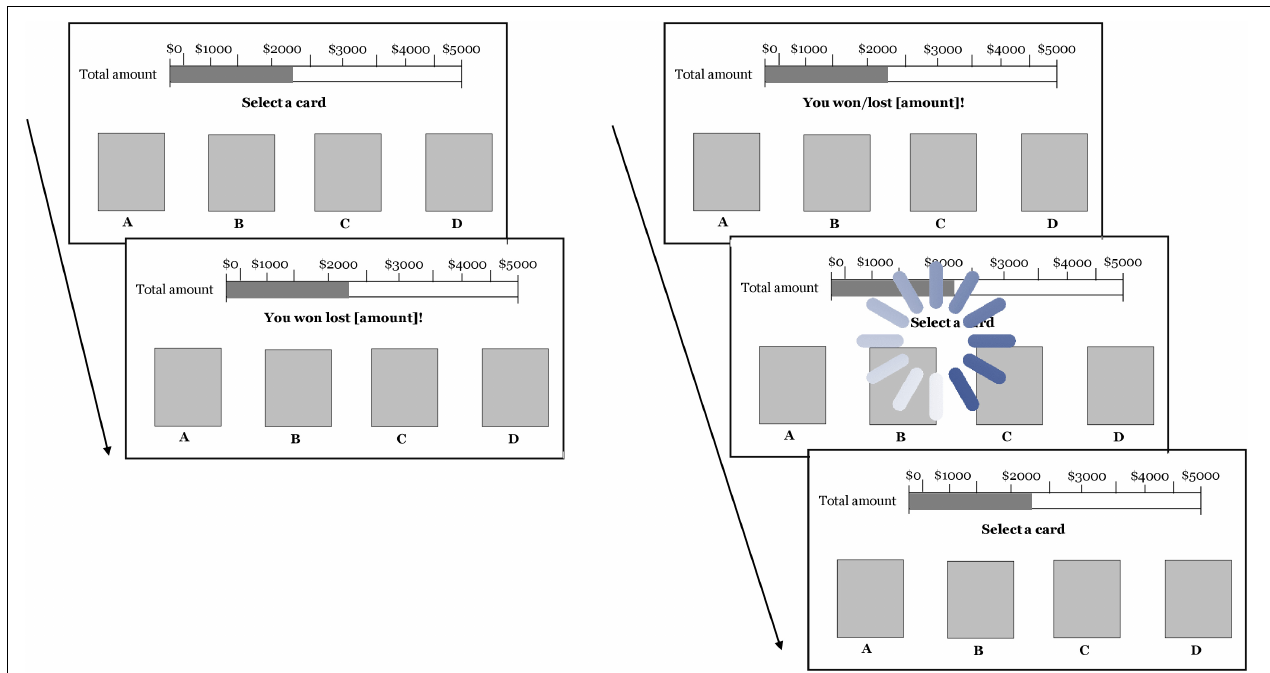
FIGURE 4 | Illustrations of the stress manipulations used in this study. (Left image) Induction of perceived financial loss as a negative financial outcome of the decision-making task. (Right image) Induction of perceived techno-unreliability in the form of system response time (SRT) delays as an animated spinning wheel momentarily preventing participants from carrying on their financial